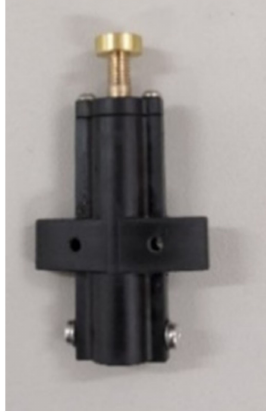
Figure 3. Photo of Mechanical overload